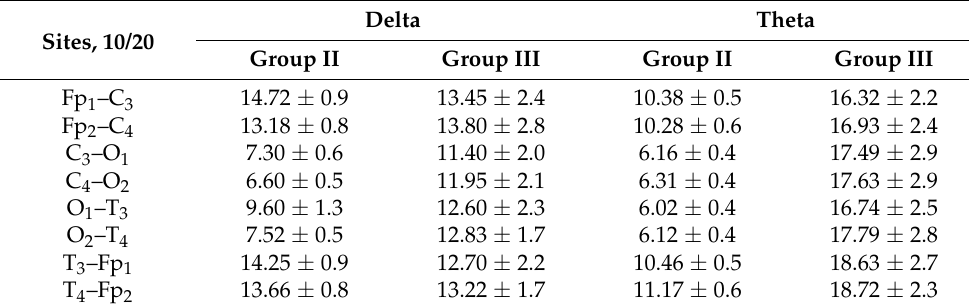
Table 2. EEG power spectra (%) in delta and theta ranges.